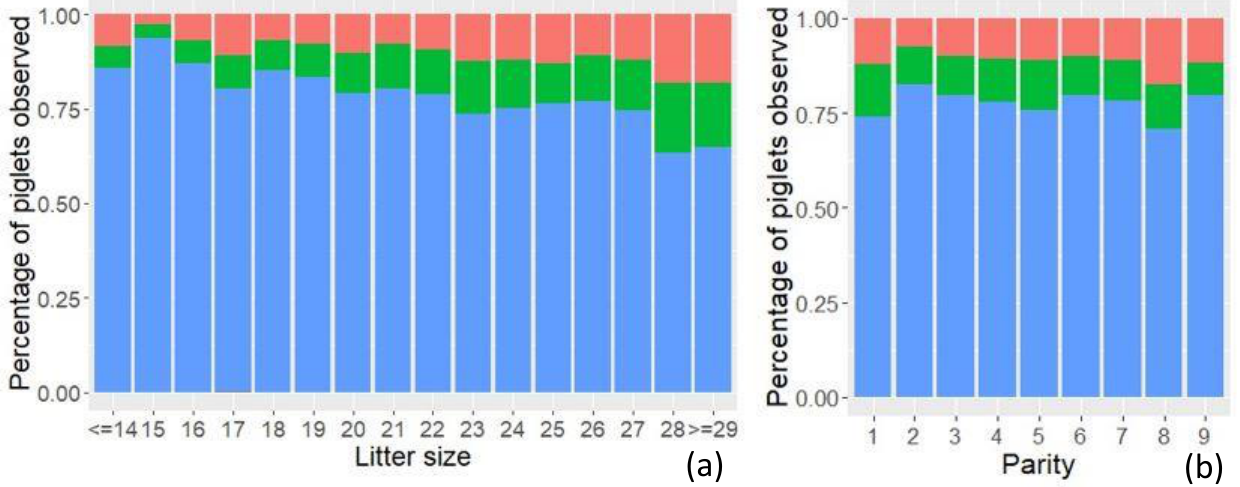
Figure 6. Percentage of normal (blue), mild IUGR (mIUGR (green)) and severe IUGR (sIUGR (red)) piglets with ( a ) increasing litter size and ( b ) of different